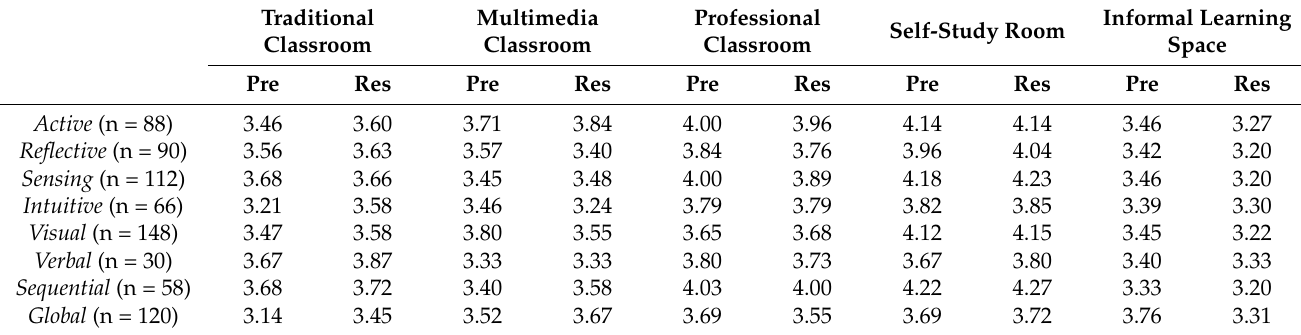
Table 3. Average scores for learning spaces by students with different learning